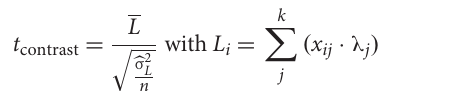
Refer to Figure 4 . Prior to training, thresholds for identifying